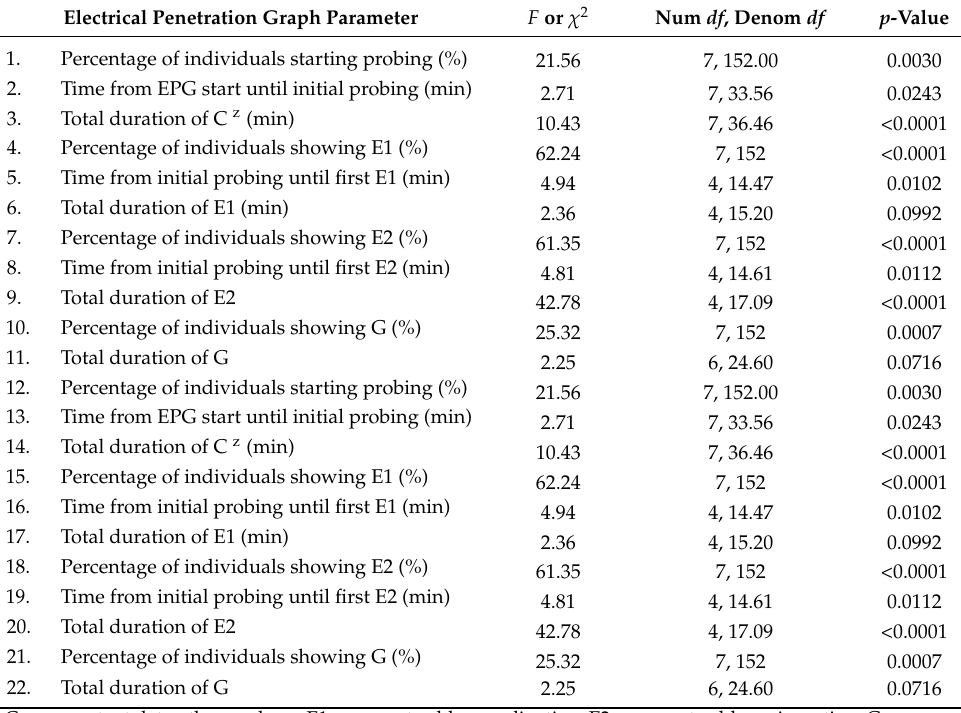
Table 3. GLM-Logistic and Welch’s ANOVA results about EPG parameters of Acanthococcus lager- stroemiae on eight different plant